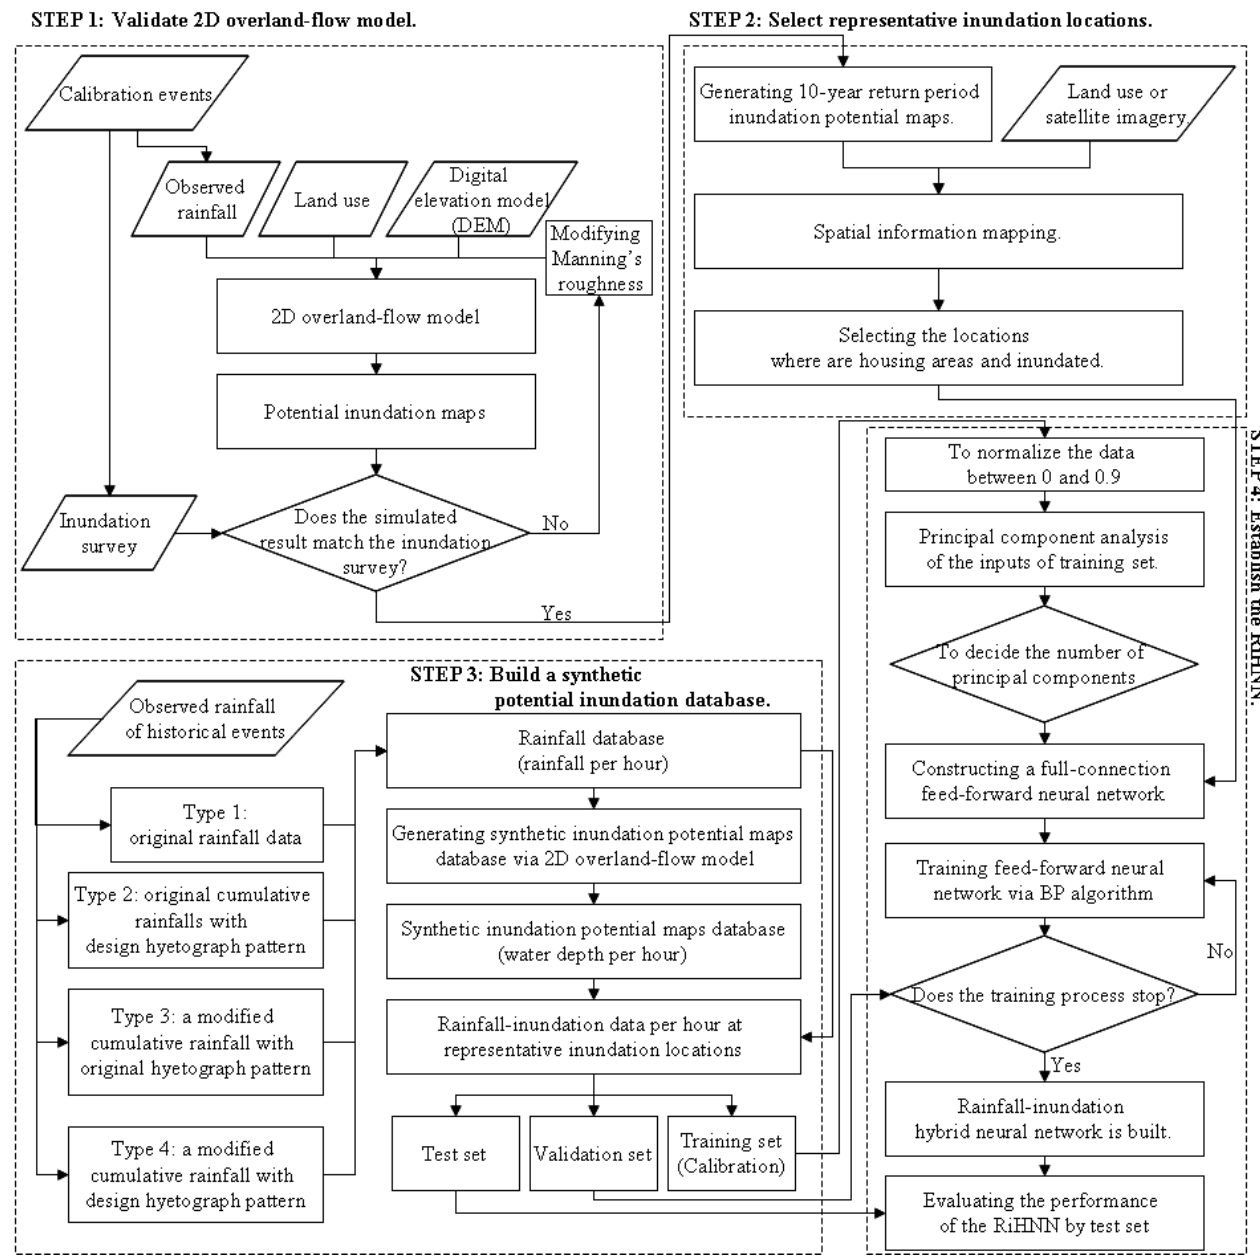
Fig. 2. The systematic procedure of building a rainfall-inundation hybrid neural